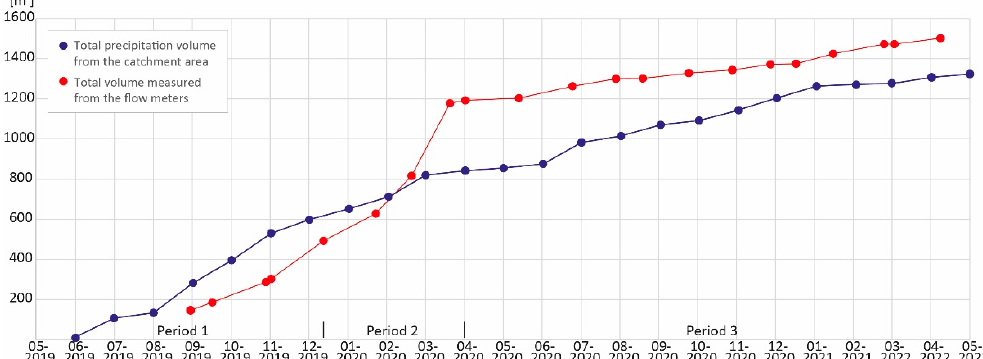
Figure 5. Precipitation from the catchment area and the water measured by the flow meters. The 3 periods are marked above the x axis.